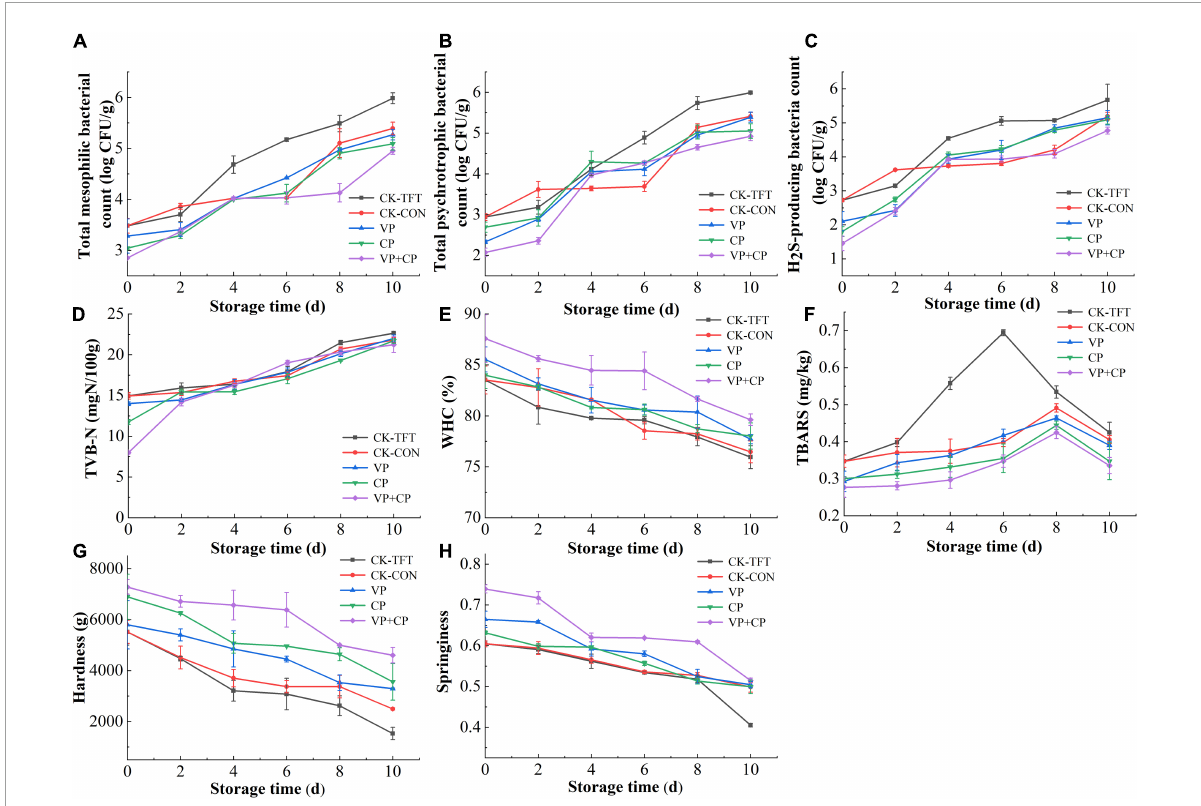
FIGURE2 Changes of microbiological and physiochemical indicators of salmon treated by curcumin and piperine combined with vacuum packaging during cold chain logistics: (A) Total mesophilic bacteria count (MBC); (B) total psychrotrophic bacteria count (PBC); (C) H 2 S-producing bacteria count (HSPBC); (D) TVB-N; (E) WHC; (F) TBARS; (G) hardness; (H)